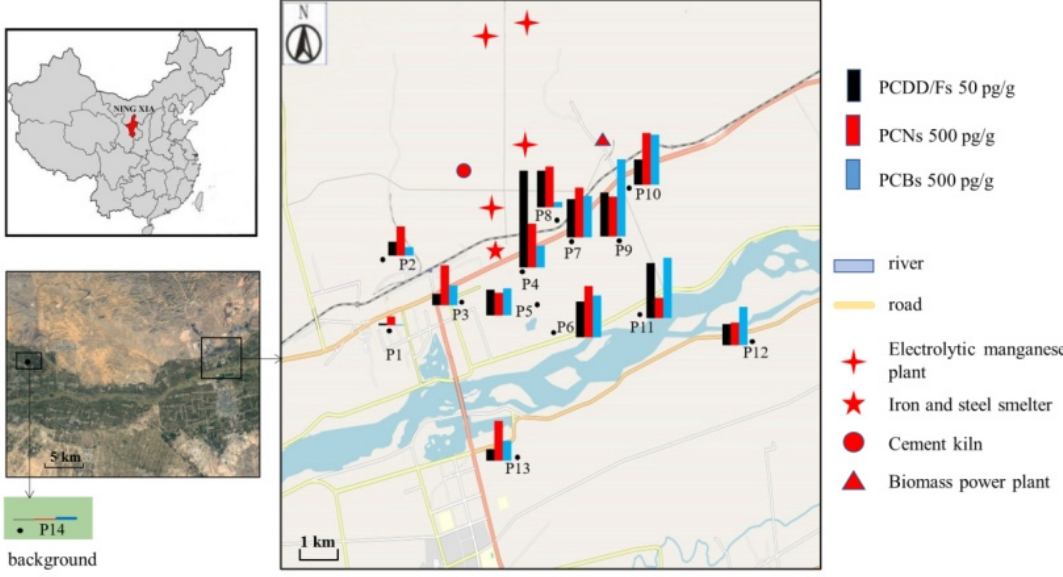
Figure 1. Soil sampling locations and concentrations of PCBs, PCDD/Fs, and PCNs in soil samples collected around the industrial park.